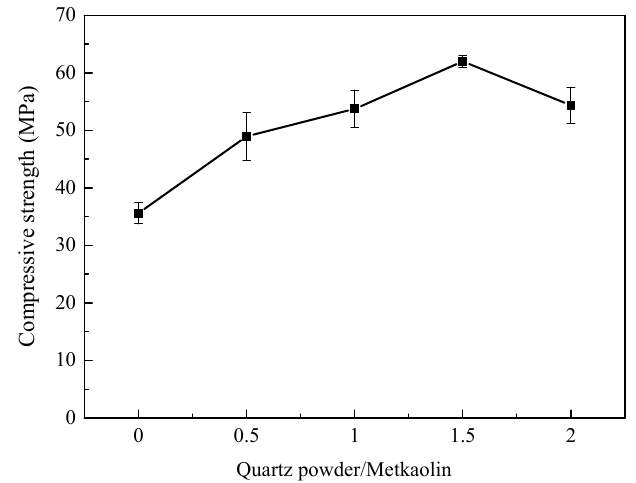
Figure 2. Compressive strength of HMGC with different quartz powder